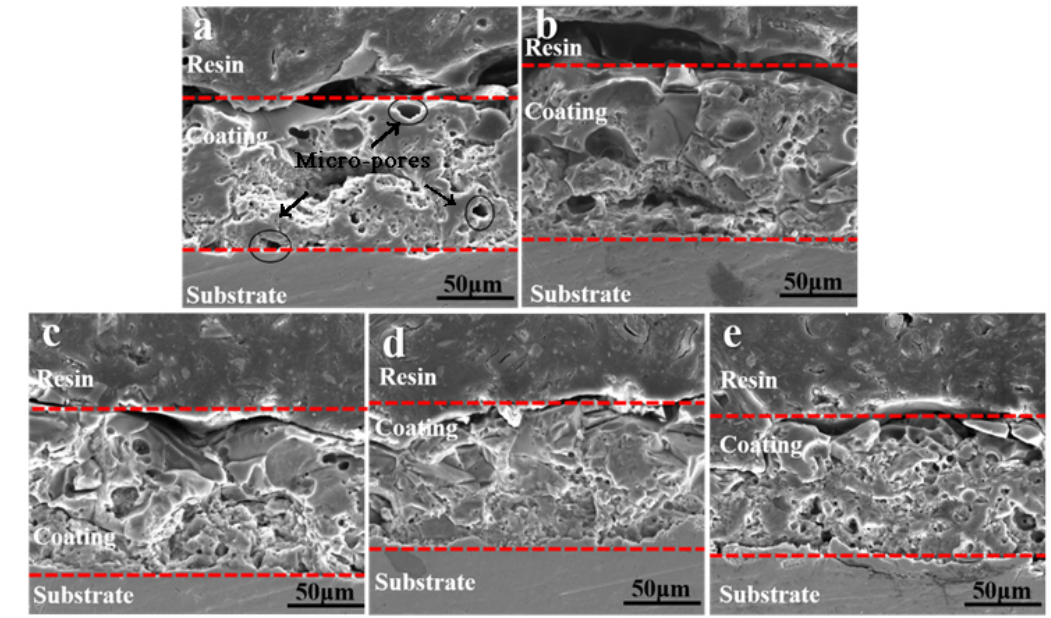
Figure 5. Cross-section morphology of MAO coatings ( a ) S0; ( b ) S1; ( c ) S2; ( d ) S3; ( e ) S4.